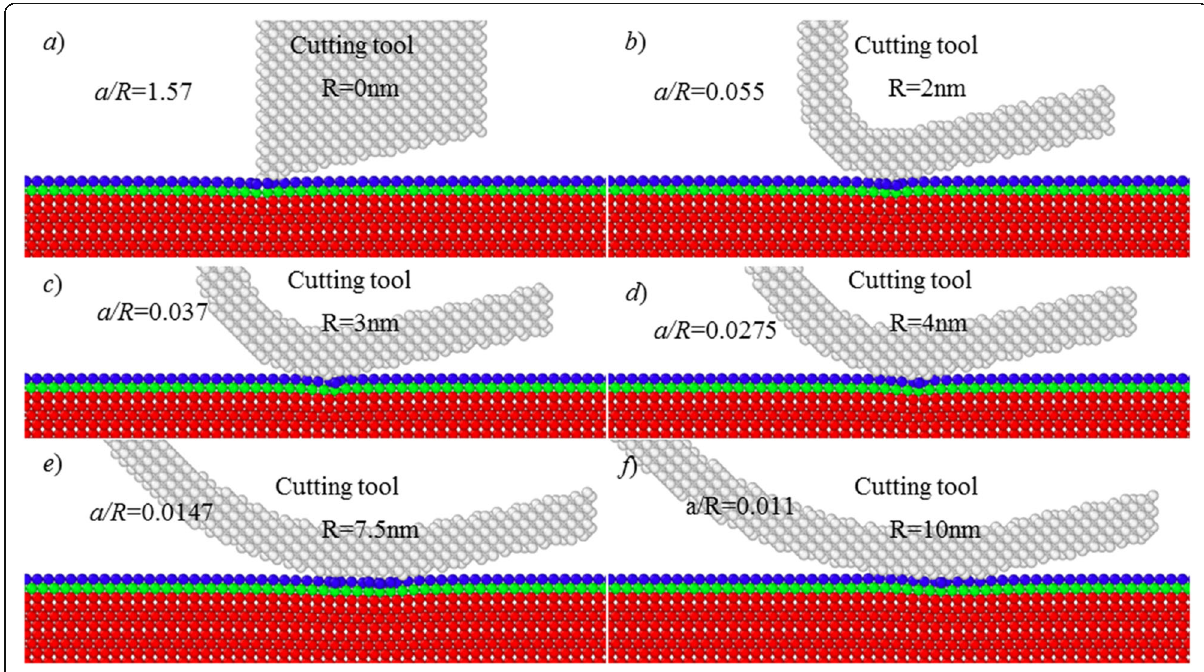
Fig. 3 Simulation results at cutting depth of 1.1